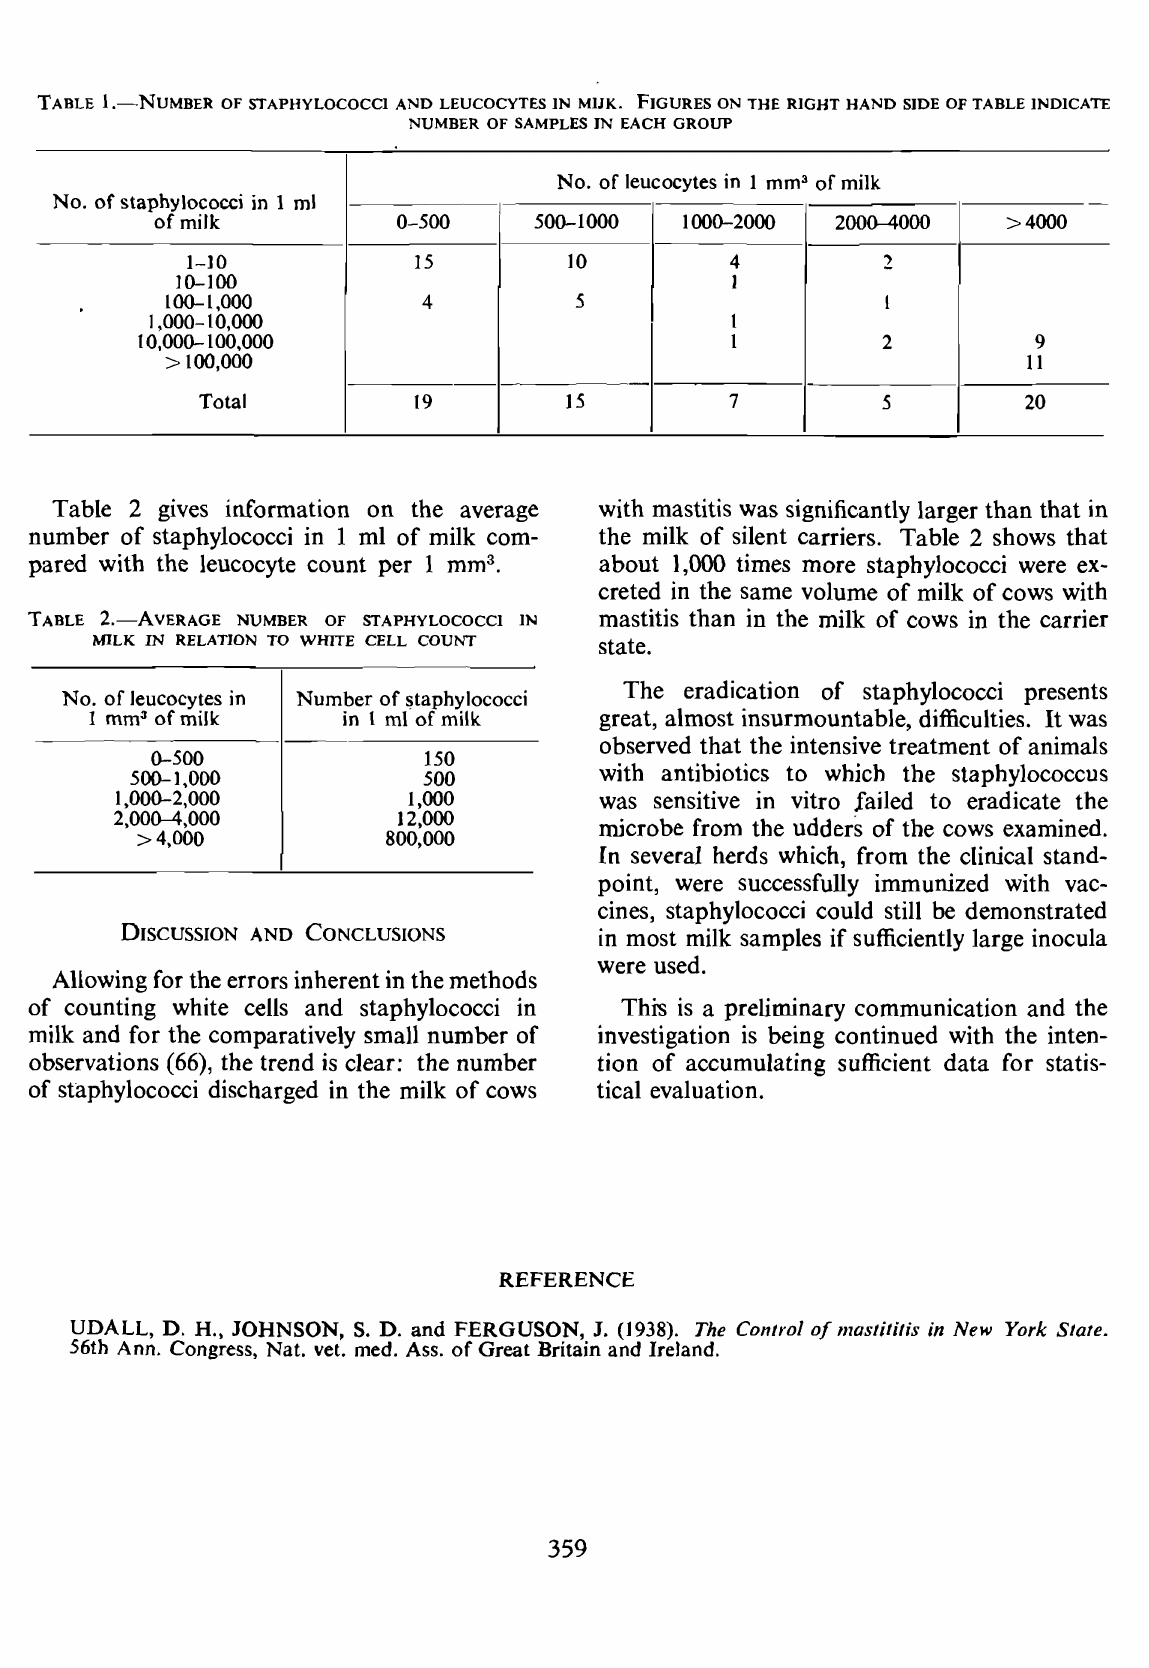
TABLE i.-NUMBER OF STAPHYLOCOCCI AND LEUCOCYTES IN MUK. FIGURES ON THE RIGHT HAND SIDE OF TABLE INDICATE NUMBER OF SAMPLES IN EACH GROUP